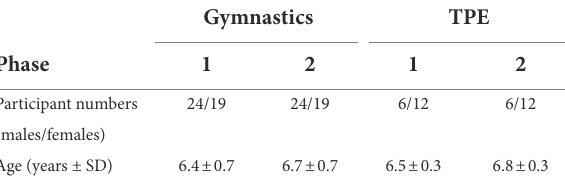
TABLE 1 Gymnastics and TPE group participants’ age and sex at each phase of data collection. Gymnastics